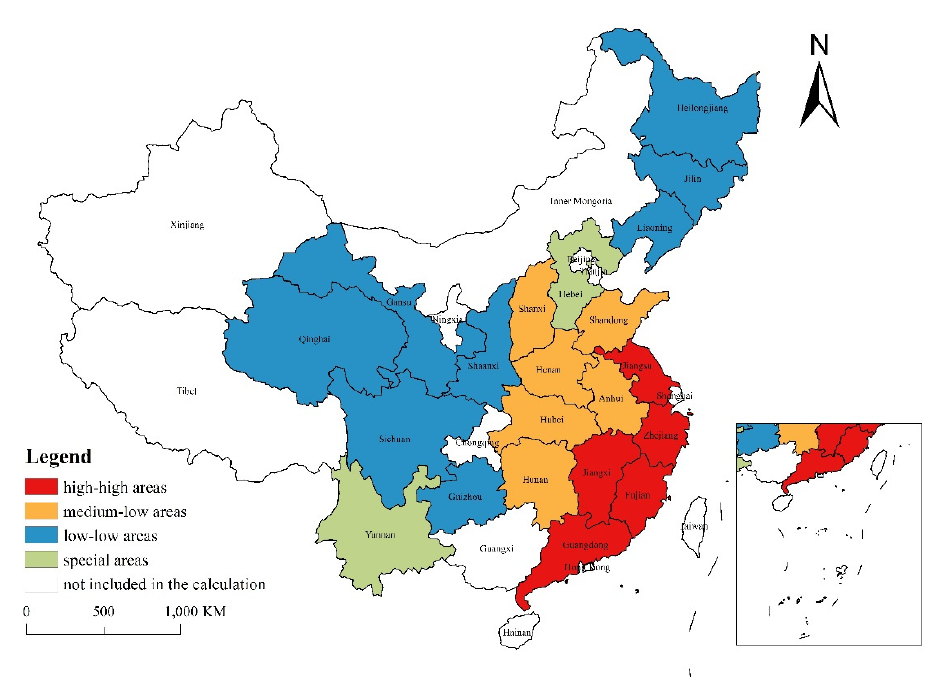
Figure 9. Schematic diagram of classification of some Chinese provinces based on P and U values in 2010 (created by ArcGIS, and data source is the sixth population census of China).